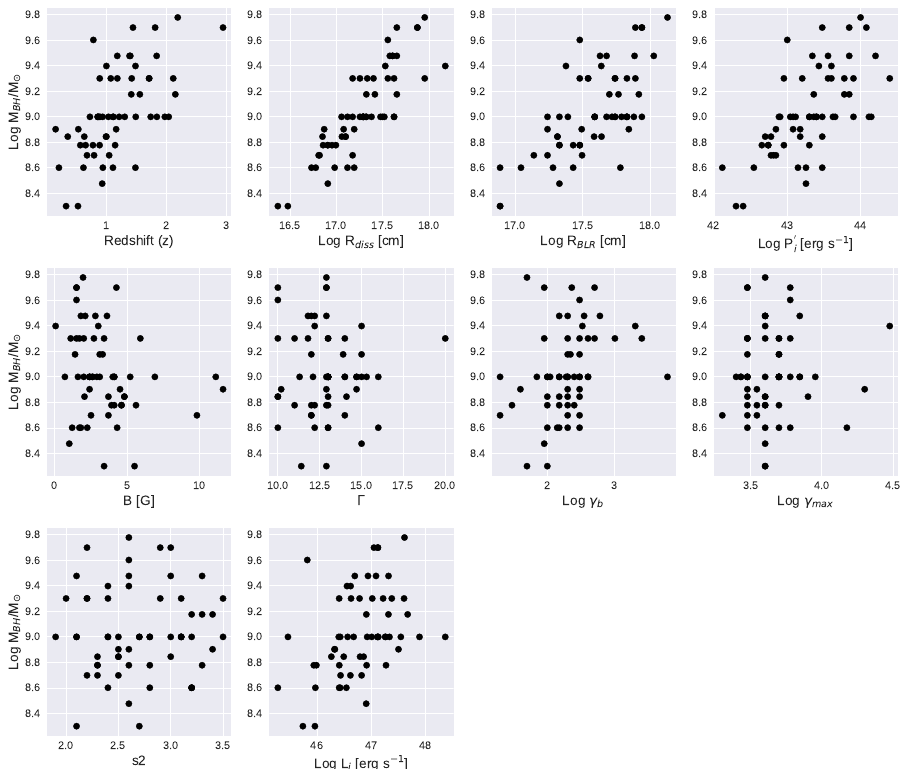
Figure 2. Scatter plots for the mass of SMBH as a function of SED model parameters of the blazar data